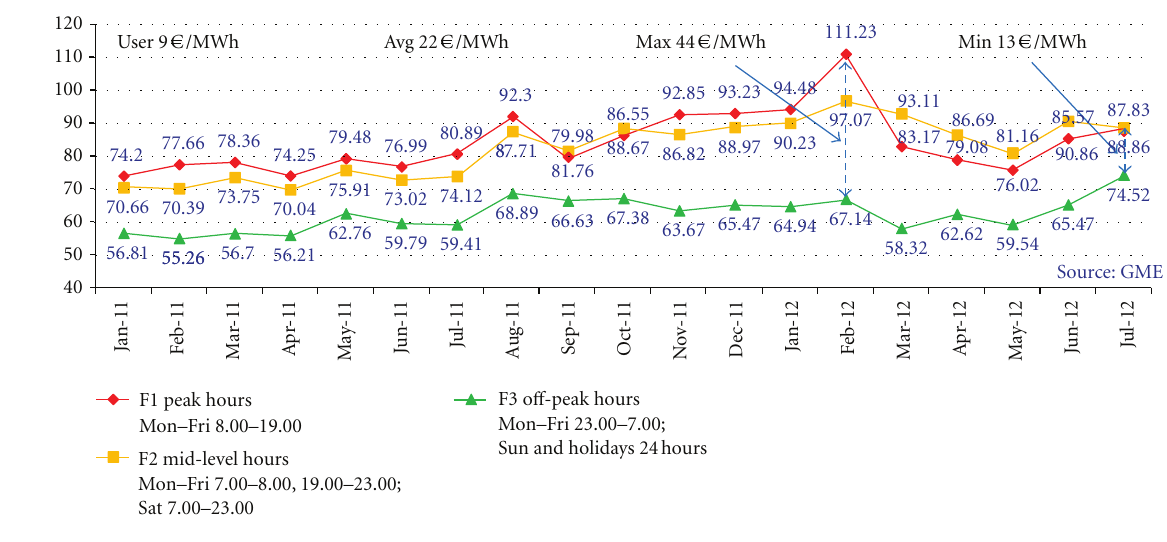
Figure 8: Cost of energy in di ff erent time ranges in